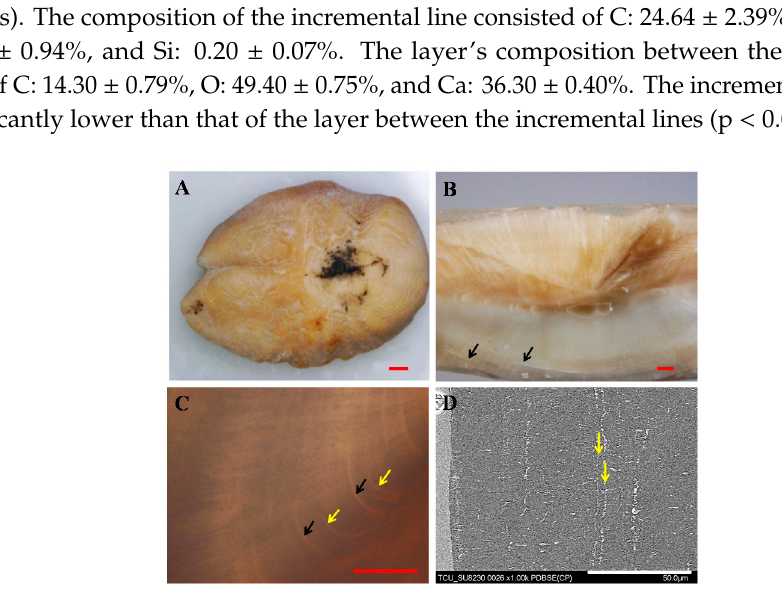
Figure 2. Micrograph of Lobianchia gemellarii (Cocco). The narrower incremental lines were unclear and irregularly observed ( B – D ). The long-period incremental lines (average 41 μ m: yellow arrows and average 66 μ m: black arrows) were observed ( B,C ). Digital microscopy images ( A : otolith surface, between the incremental lines consisted of C: 11.46 ± 0.34%, O: 46.66 ± 0.74%, and Ca: 41.89 ± 0.73%. B : cross-sectional image). Polarizing micrograph of the ground specimen ( C ). SEM micrograph ( D ). The incremental line Ca content was significantly lower than that of the layer between the incremental Scale bar: 500 μ m ( A ), 100 μ m ( B ), 50 μ m ( C , D ). lines (p < 0.05, n =